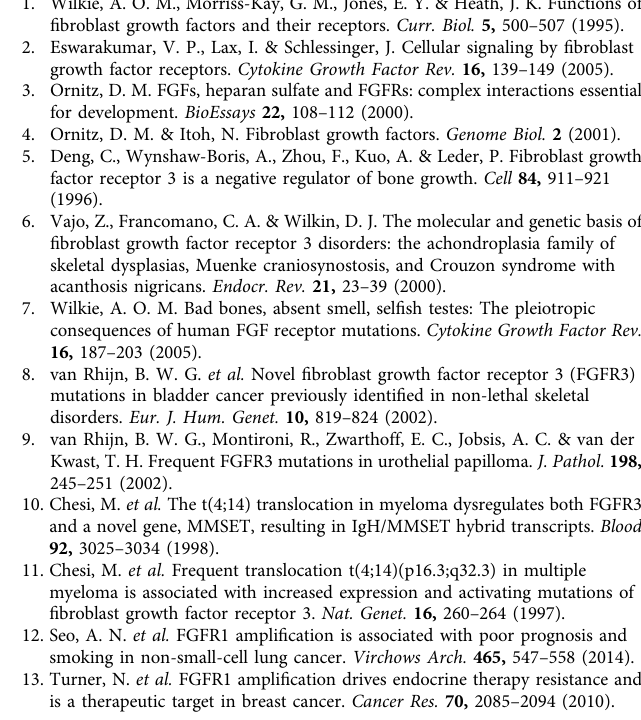
ffiffiffiffiffiffiffiffiffiffiffiffiffiffiffiffiffi 1 þ 8 TK p (cid:2) 1 (cid:3)